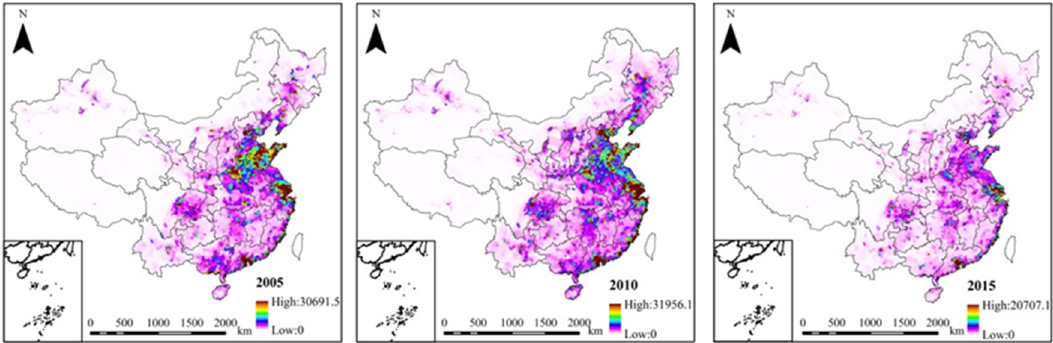
Figure 12. Spatial distribution map of GDP in 2005, 2010, and 2015.